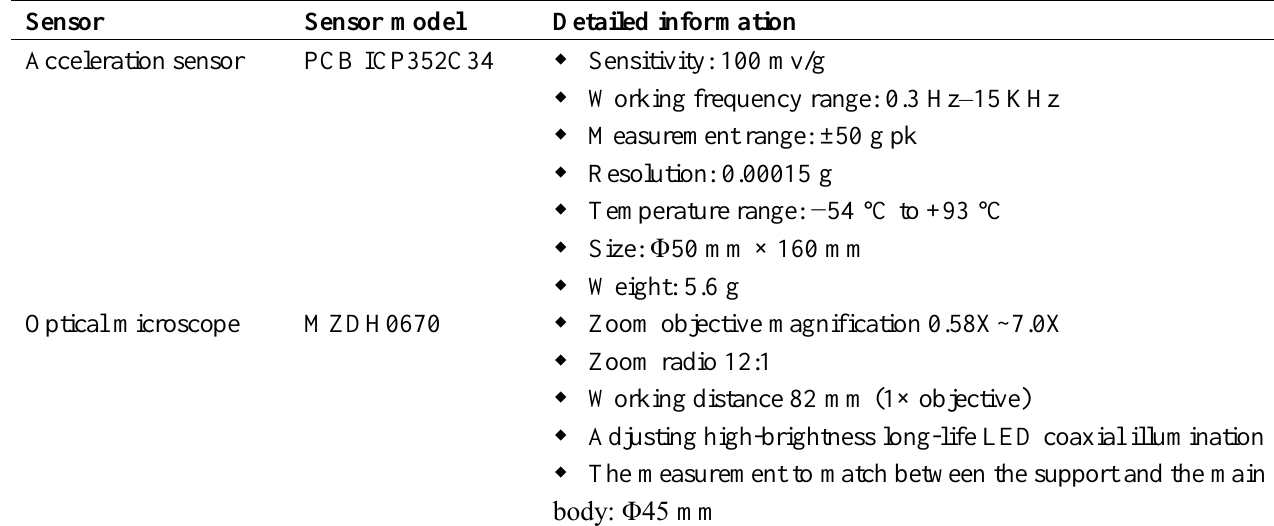
Table 2. Detailed information of the